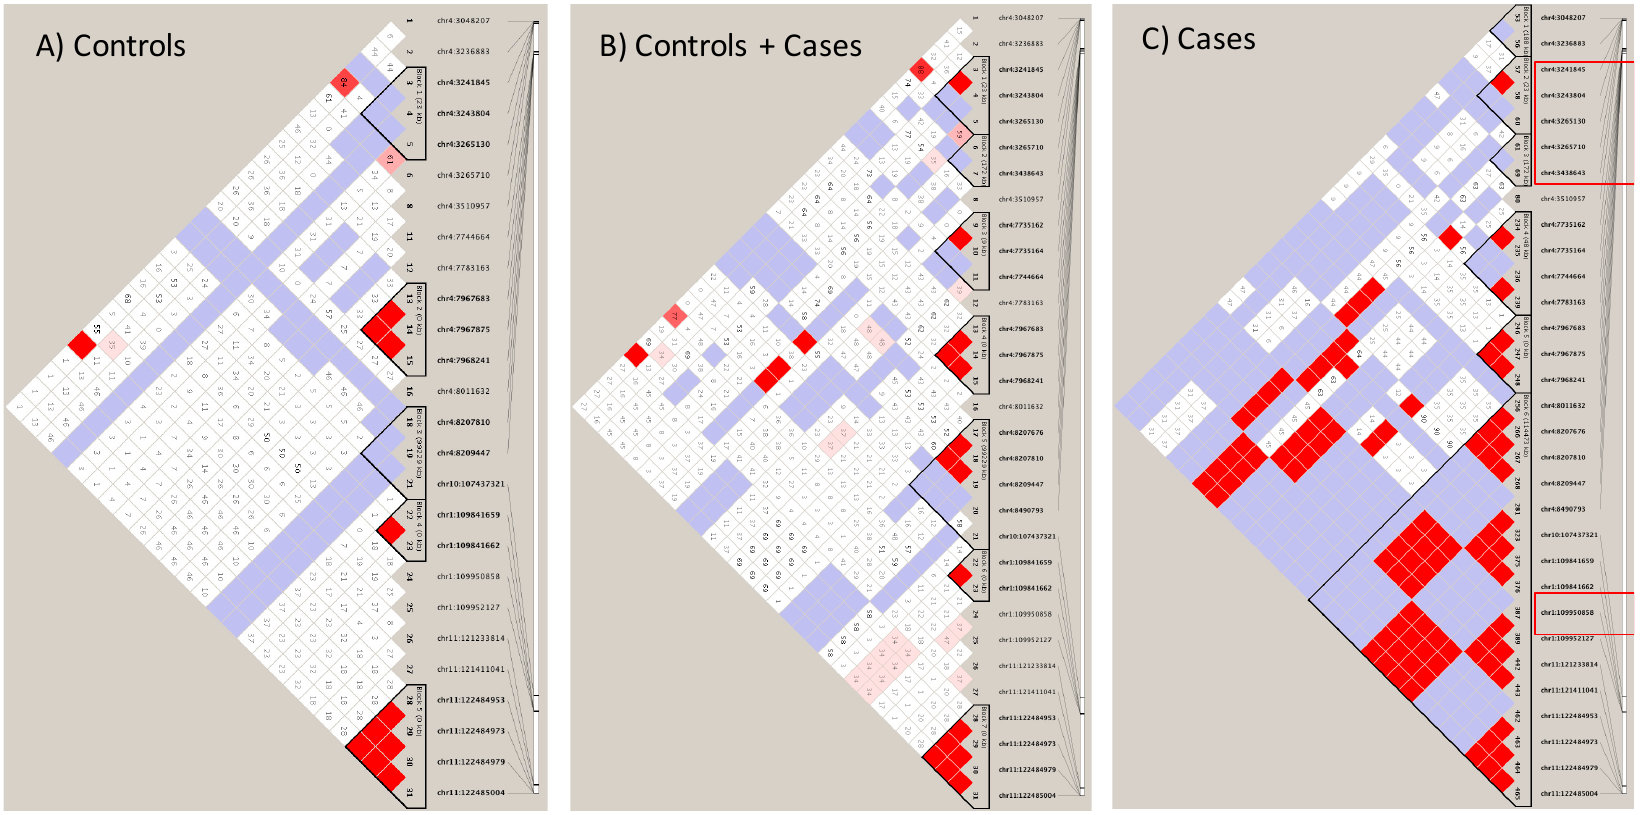
Figure 5. Linkage Disequilibrium of sortilin variants with HTT in human cases of the Labadorf dataset. Coordinates in chromosome 4 represent SNPs in the HTT and SORCS2 . Coordinates in chromosome 10 represent SNPs in SORCS1 and SORCS3 . Coordinates in chromosome 1 and 11 represent SNPs in SORT1 and SORL1, respectively. ( A ) Genotypes of control individuals; ( B ) genotypes of the control and cases combined; ( C ) genotypes of cases. High Linkage indicated by the shades of red between the HTT (position 3–3.2M of chromosome 4) and all sortilins.